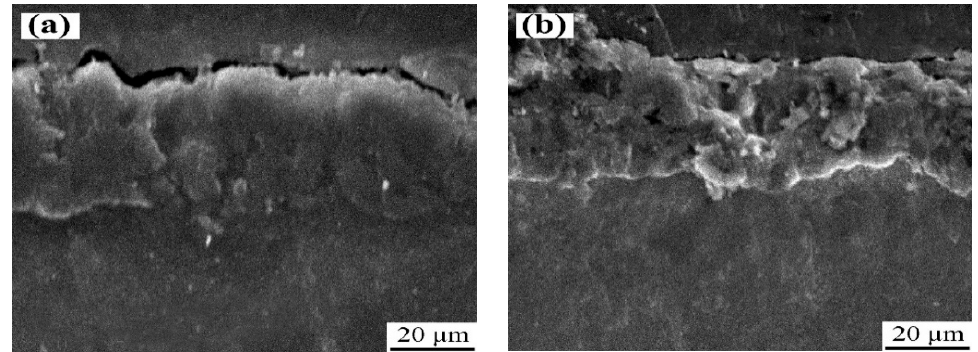
Figure 6. The cross-section morphology of MAO coatings in power supply mode of pulse bipolar current ( a ) and pulse with a discharge loop current ( b ).